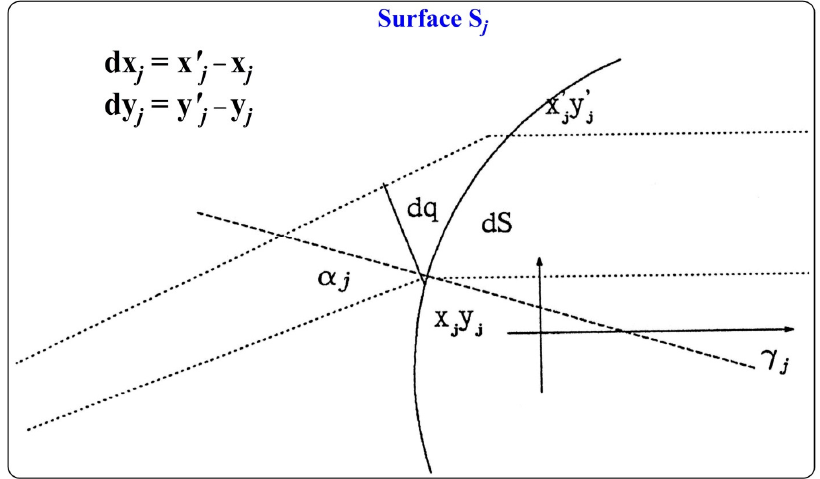
Figure 4. The determination of differentials for rays and surfaces.